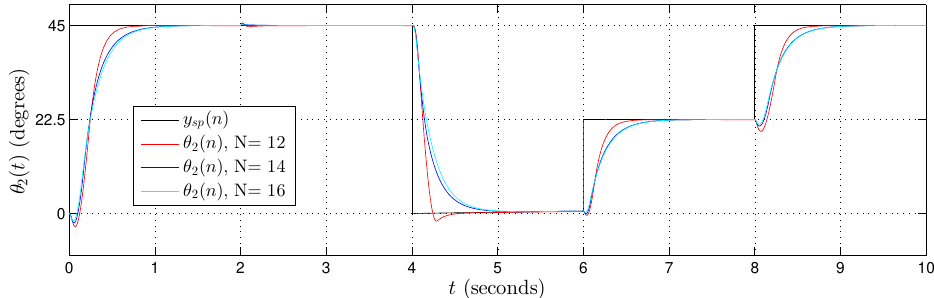
Figure 23. Validation results from the proposed Takagi–Sugeno Fuzzy-PI hardware. Simulation trajectory for θ 2 ( t ) with θ 2 ( n ) using N = { 12,14,16 } bits in the fractional part.